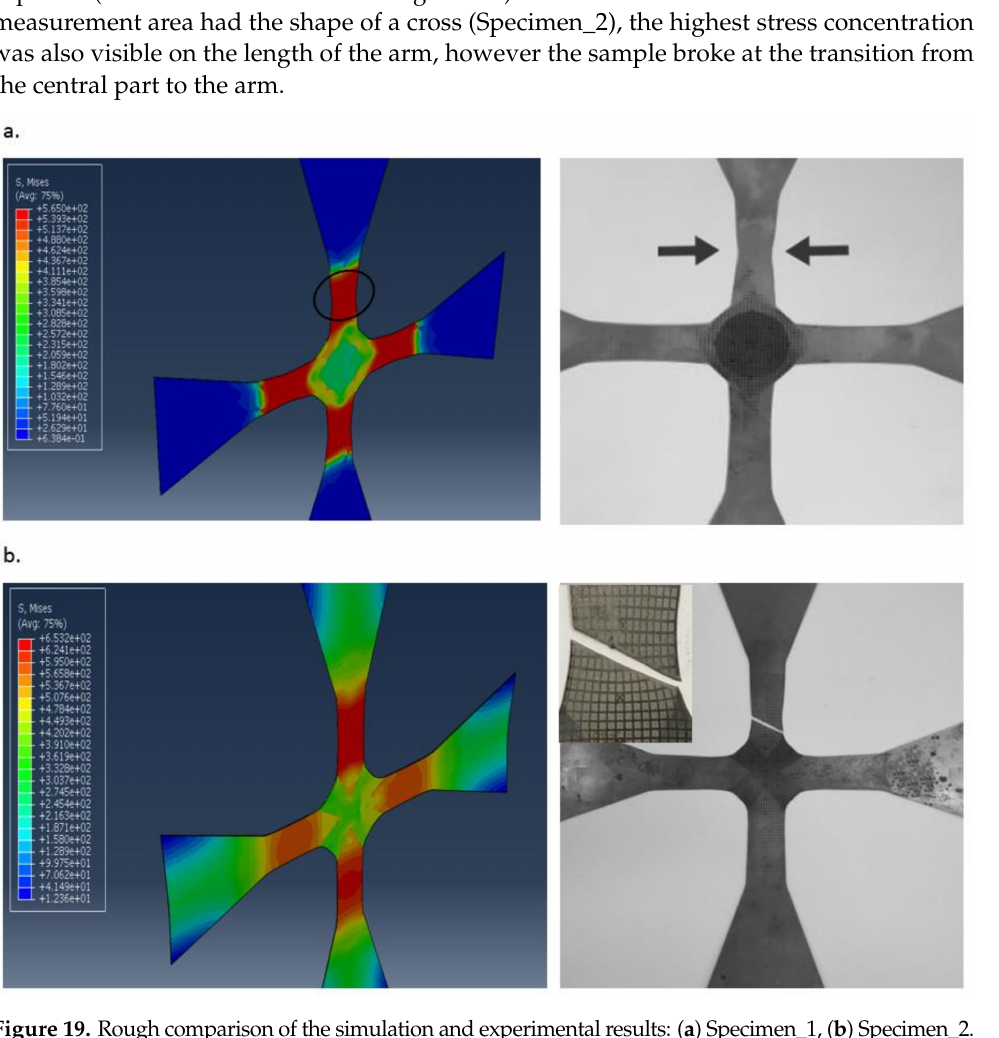
Figure 19. Rough comparison of the simulation and experimental results: ( a ) Specimen_1, ( b )